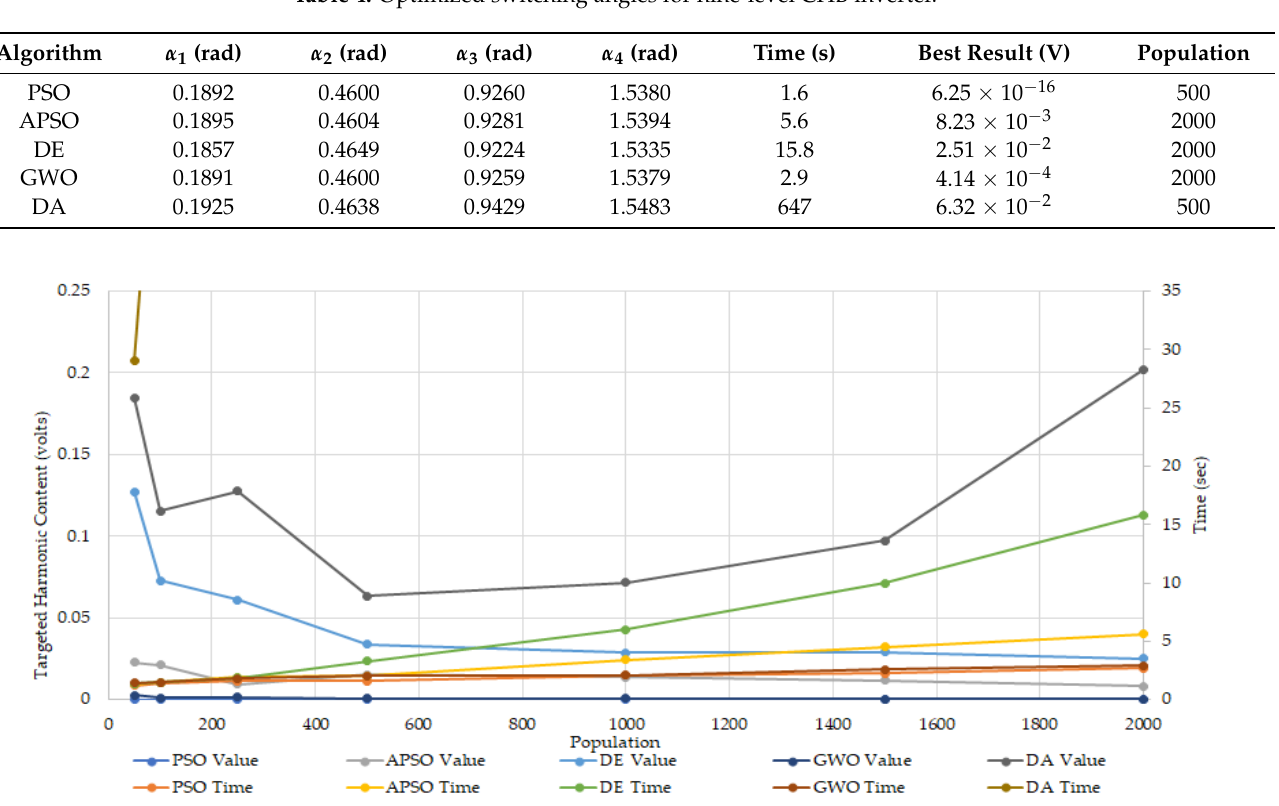
Figure 7. Summary of algorithms’ performance for a nine-level inverter.